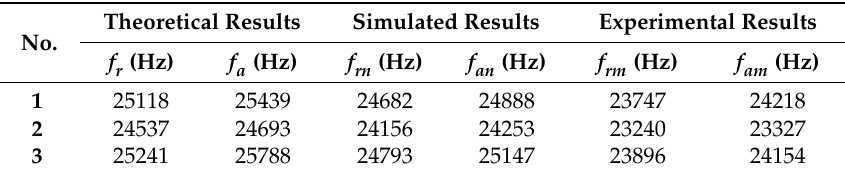
Table 3. The theoretical, simulated, and experimental resonance/anti-resonance frequencies of the transducers at the second